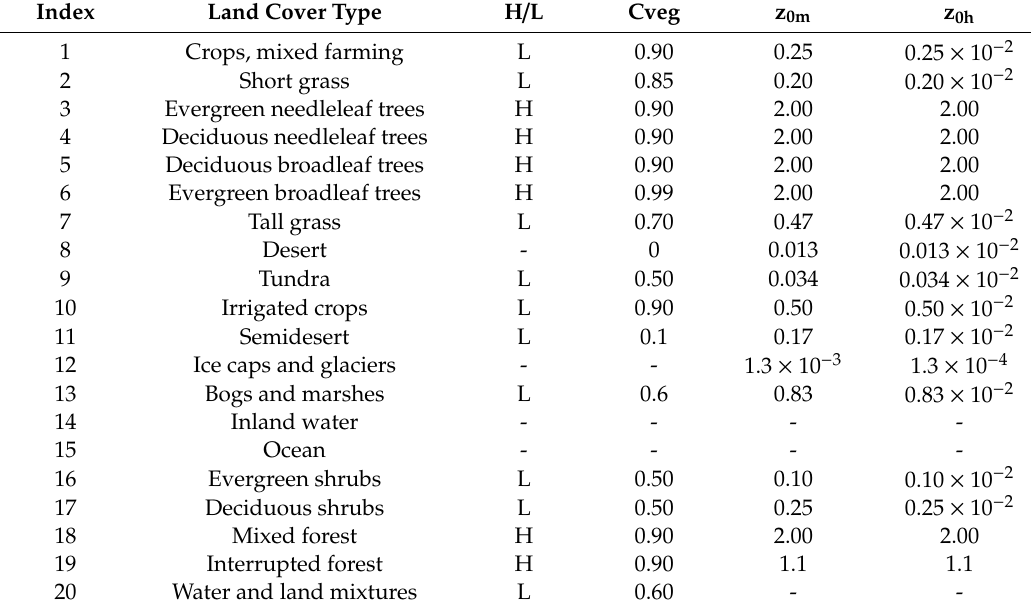
Table 1. HTESSEL land cover types and associated parameters’ values. H / L di ff erentiates low (L) from high (H) vegetation; cveg is the vegetation density (0–1) used in the tile fraction definition; and z0m and z0h are the roughness lengths for momentum and heat, respectively used in the calculations of the turbulent exchange coe ffi cients for momentum, heat and